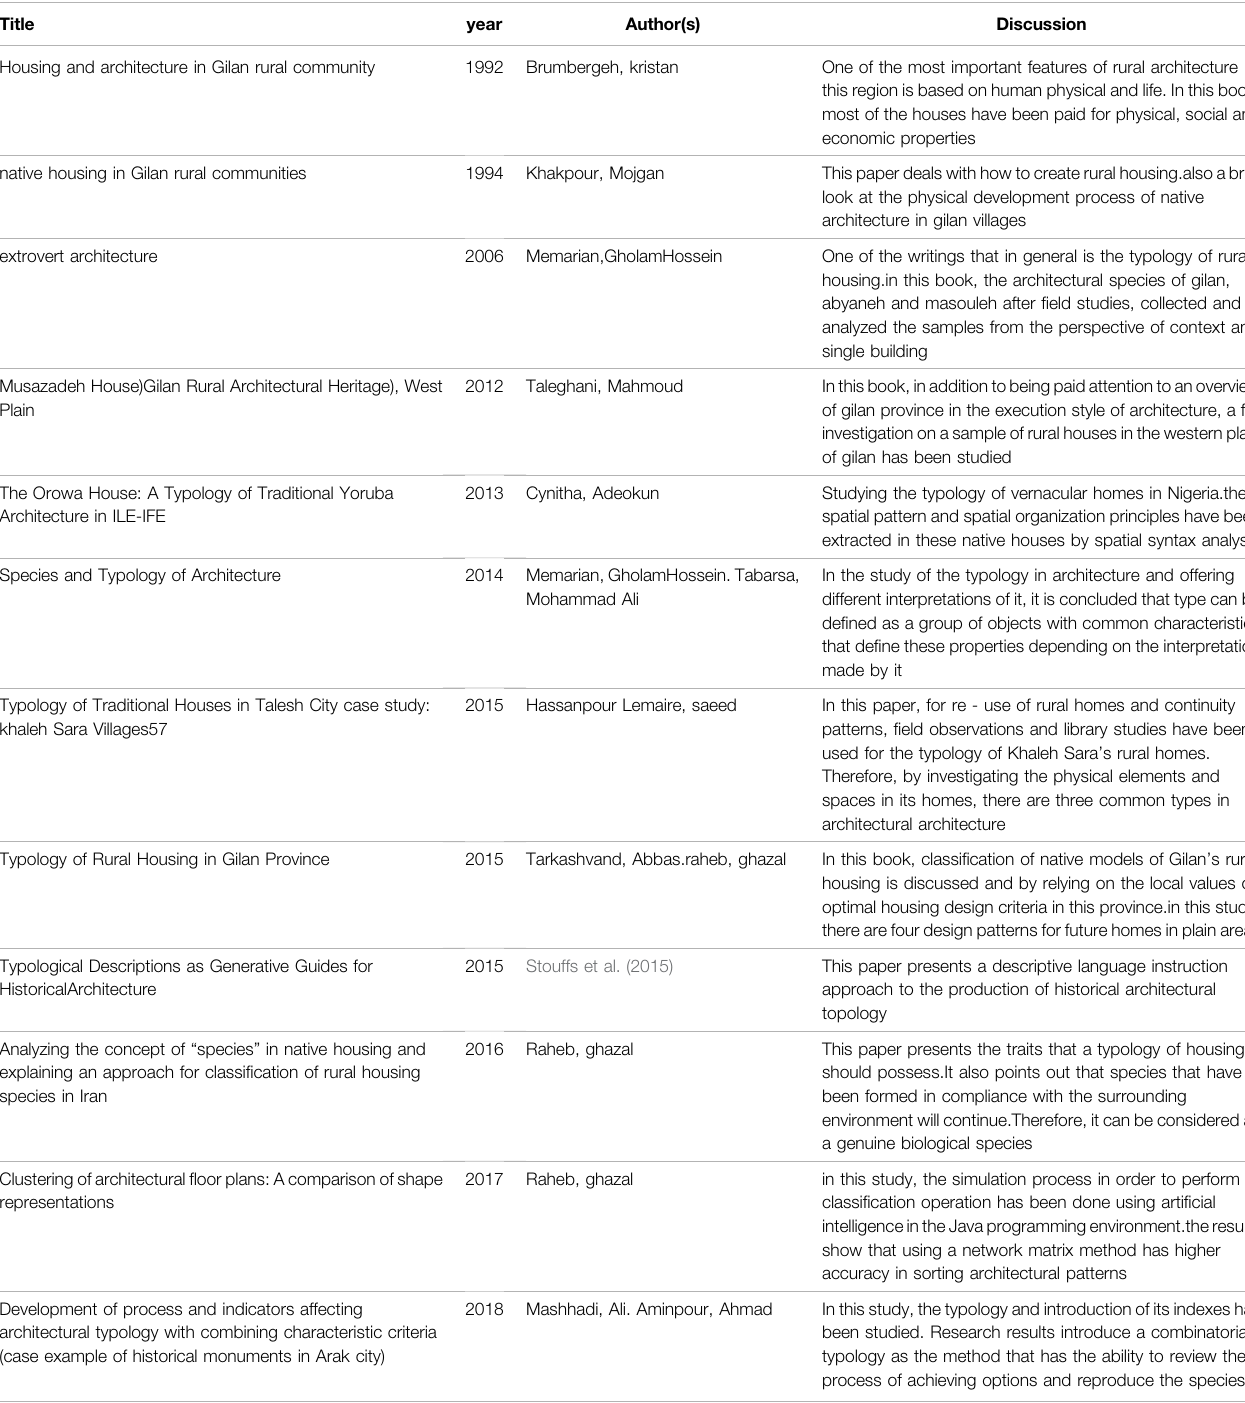
TABLE 1 | Classi fi cation of research done in the fi eld of